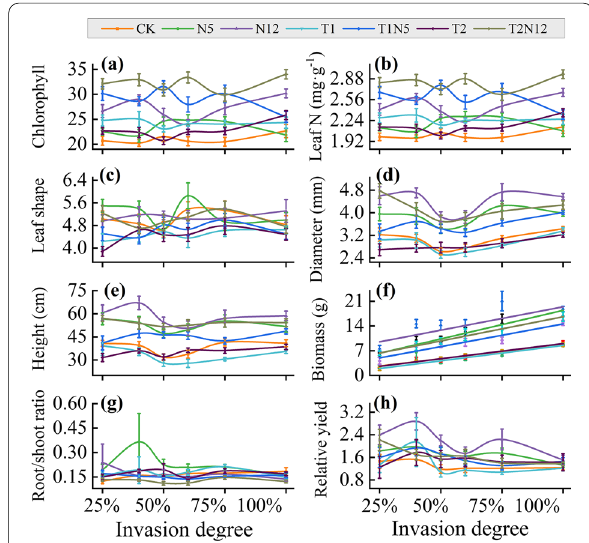
Fig. 4 Effects of environmental change on the invasion process of Solidago canadensis . Linear regression models were fitted to determine the effect of invasion degree on growth parameters as well as on the competitiveness of S. canadensis . Data that did not fit a linear regression model (non-linear response to invasion levels) were analyzed using locally estimated scatterplot smoothing (LOESS) regression, and connected by modified Bezier curve. A total of seven environmental treatments were imposed: CK (control), N5 (N addition 5 g m -2 yr -1 ), N12 (N addition 12 g m -2 yr -1 ), T1 (temperature increase of 1.15 °C), T1N5 (combined 1.15 °C temperature increase and N addition of 5 g m -2 yr -1 ), T2 (temperature increase of 1.86 °C) and T2N12 (combined 1.86 °C temperature increase and N addition of 12 g m -2 yr -1 ). Error bars represent the SEs of the means ( N =